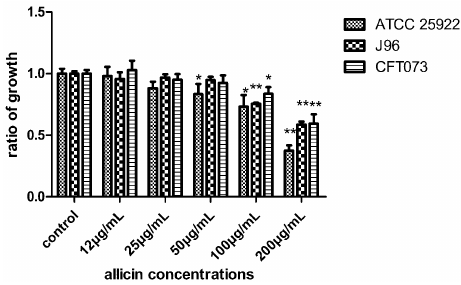
Figure 2. The growth of ATCC 25922, uropathogenic Escherichia coli (UPEC) J96, and CFT073 was evaluated by measuring optical density (OD) value at 600 nm after 24 h exposure to allicin and represented as growth ratio relative to control, set at 1. Bars indicate means ± SD of three independent experiments performed in triplicate, * p < 0.05, ** p < 0.01.